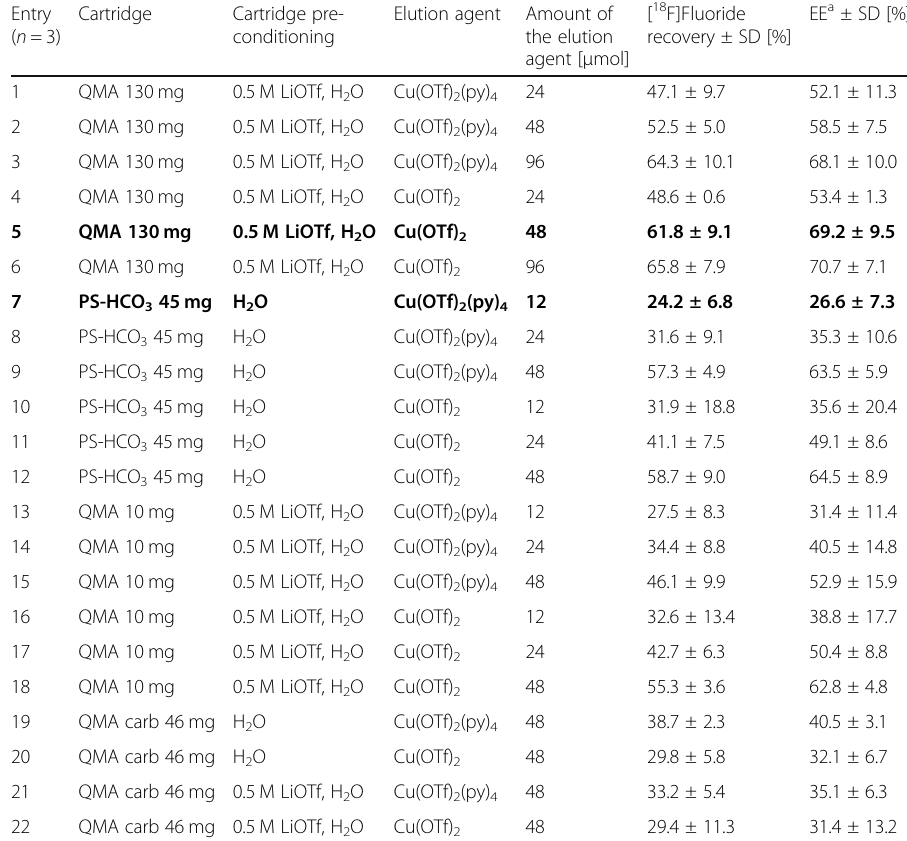
Table 2 18 F-elution varying SPE cartridges, cartridge preconditioning, and the amount of Cu(OTf) 2 or Cu(OTf) 2 (py)